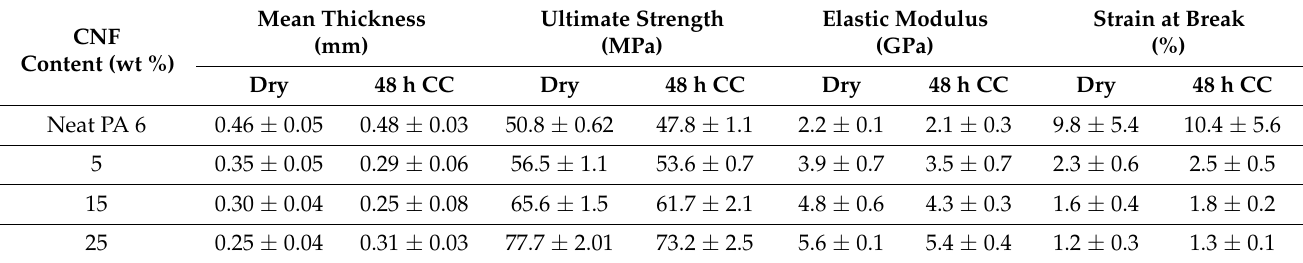
Figure 3. PA 6/CNF nanocomposites pellets and dog-bone samples for ( a ) 5 wt %, ( b ) 15 wt % and ( c ) 25 wt % formulations. Table 1. Summary of tensile test results of dry and 48 h conditioned samples for neat PA 6 and all formulations of